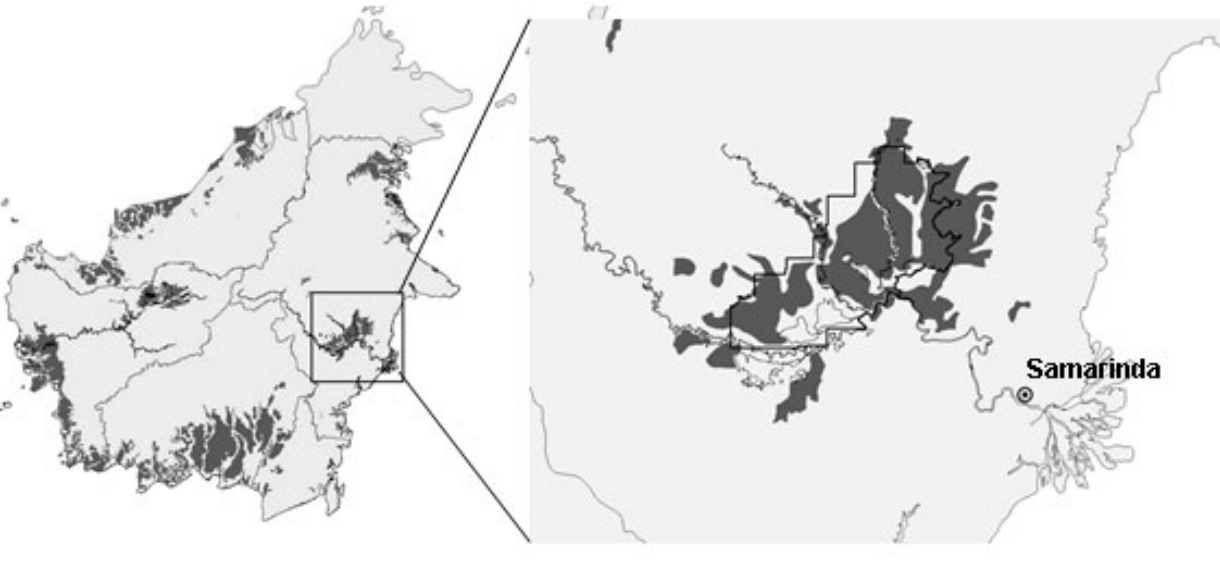
Fig. 1. Location of the Middle Mahakam Peatland study site along the Mahakam river in East Kalimantan. Dark patches are wetland areas of Borneo (Source: World Conservation Monitoring